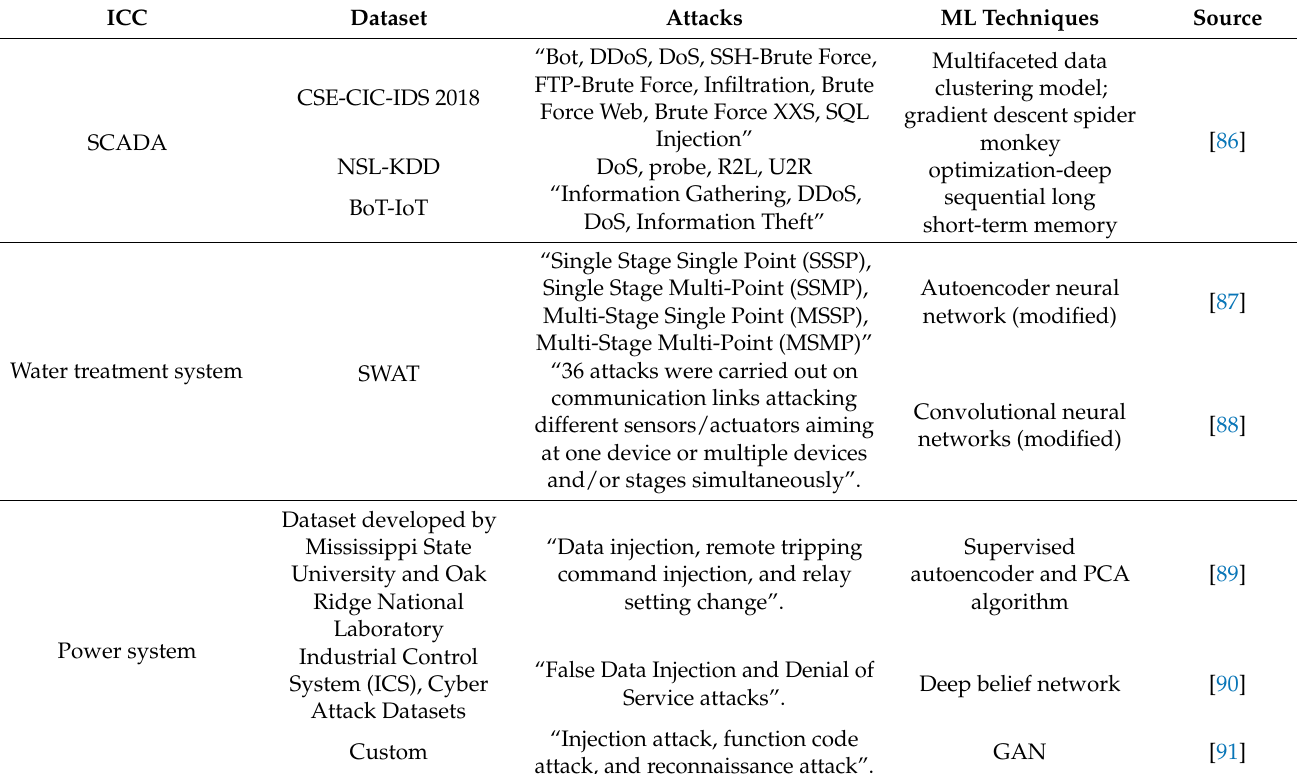
Table 7. IDSs and cyber-attacks to protect